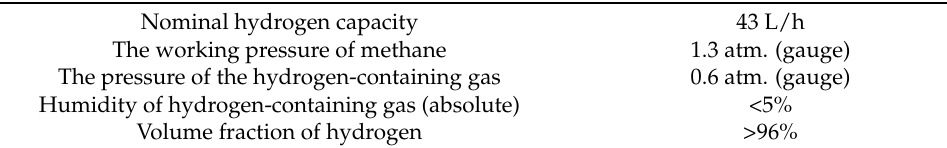
Table 2. Reformer module